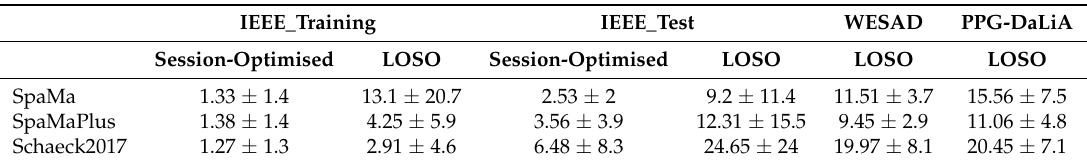
Table 4. Evaluation of the classical methods on the datasets IEEE_Training , IEEE_Test , WESAD , and PPG-DaLiA . Session-optimised results reported only for the IEEE-datasets, results from LOSO cross-validation reported for each dataset. Results are given as MAE ± STD [bpm], where standard deviation is computed on the different individual sessions.